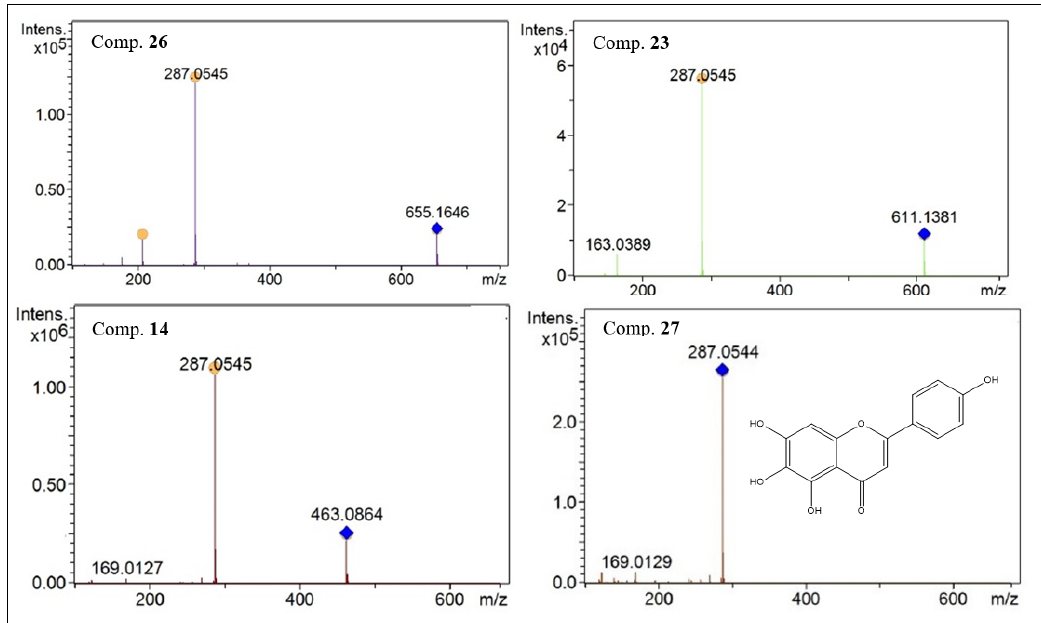
Figure 6. MS 2 spectra of flavones with scutellarein-like aglycones present in the ethanolic extract of F. chica leaves.